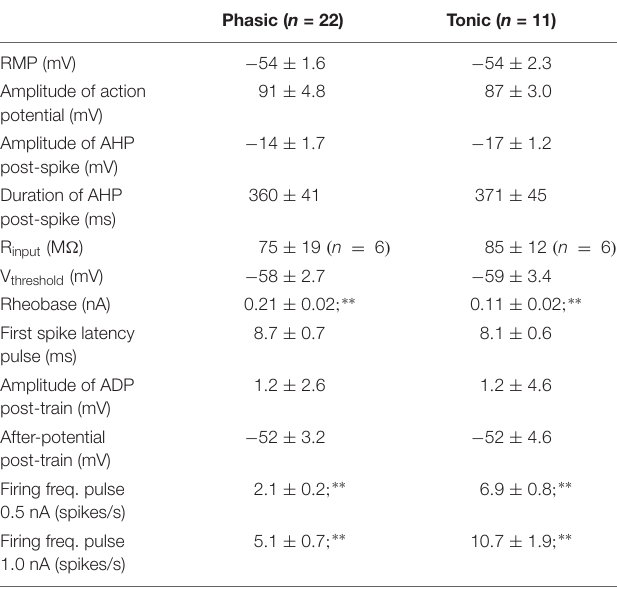
TABLE 1 | Electrophysiological properties of phasic and tonic mouse sympathetic